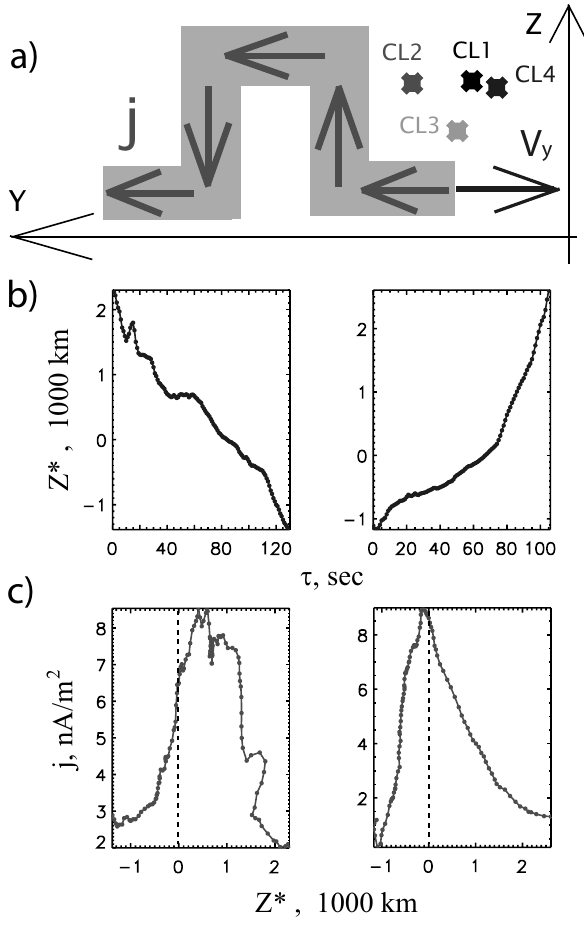
Fig. 2. ( a ) An interpretation of 12 August 2001 data: Sketch of the electric current geometry in the Y − Z plane; ( b ) Changes in the Cluster barycenter position during the crossings with respect to the neutral sheet ( Z ∗ =0); ( c ) Reconstructed current density profiles.